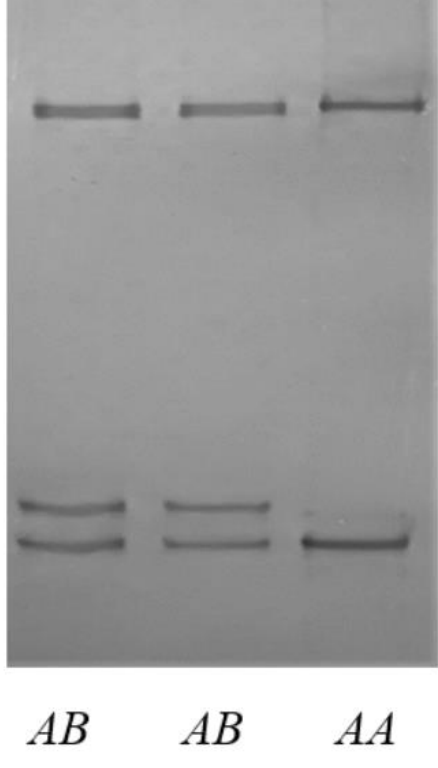
Figure 1. PCR-SSCP banding patterns for deer MSTN intron 1. Two banding patterns representing two variants A and B are shown in either homozygous or heterozygous forms.